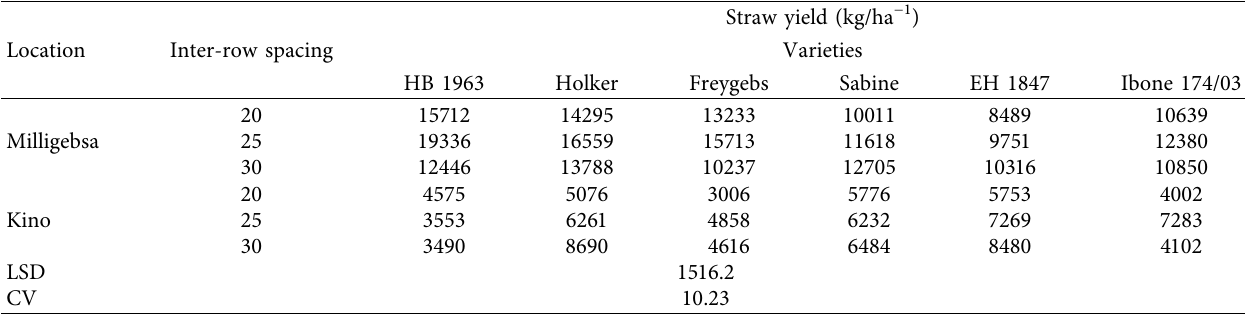
Table 9: Interaction effect of varieties, inter-row spacing, and location on straw yield of malt barley at Debark, north Gondar, Ethiopia, in 2019.